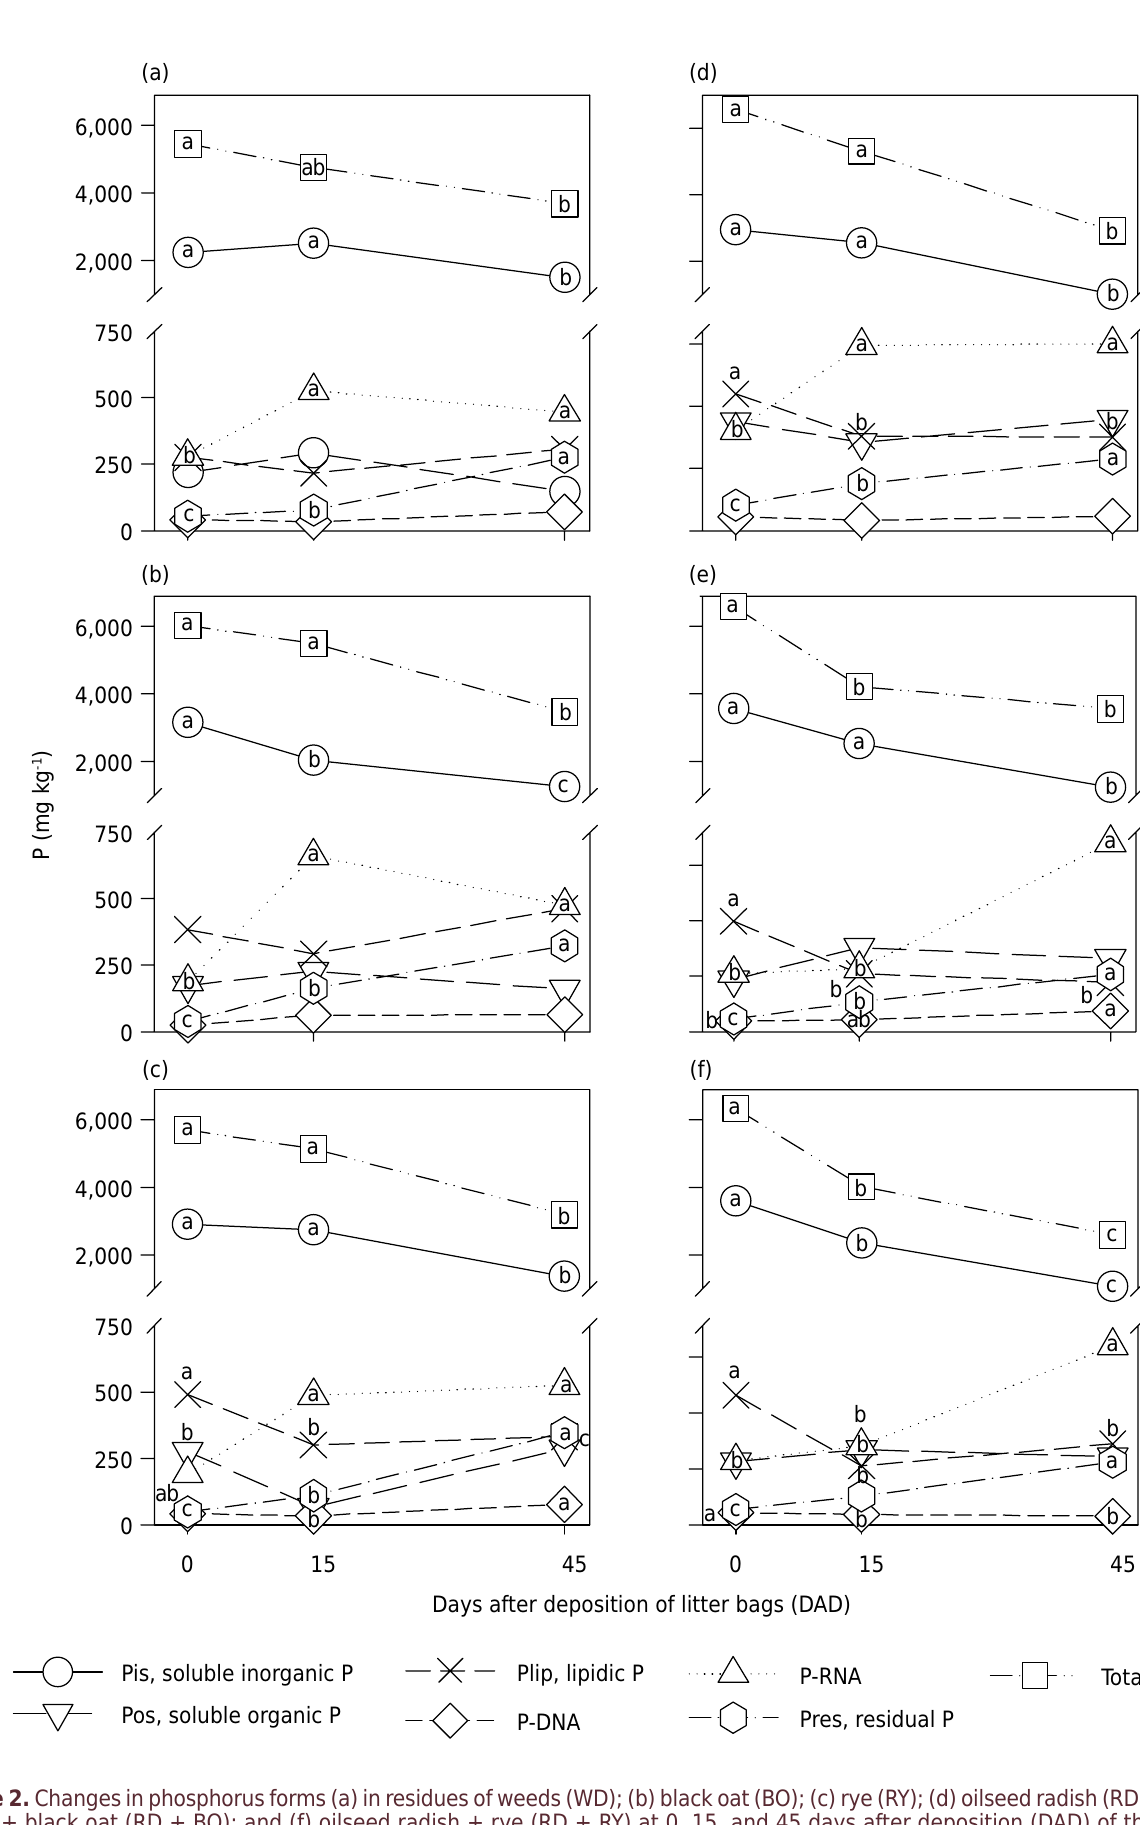
Figure 2. Changes in phosphorus forms (a) in residues of weeds (WD); (b) black oat (BO); (c) rye (RY); (d) oilseed radish (RD); (e) oilseed radish + black oat (RD + BO); and (f) oilseed radish + rye (RD + RY) at 0, 15, and 45 days after deposition (DAD) of the litterbags on the soil surface in agroecological no-till onion. Means followed by the same letter in DAD do not differ by the Tukey test